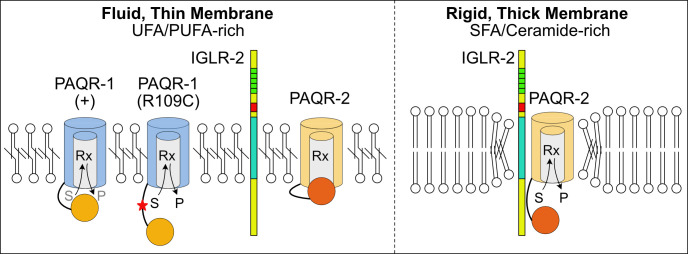
Speculative mechanism of PAQR-1/PAQR-2 regulation.We propose that the cytoplasmic domain (orange/red circles) can regulate access to the catalytic site (Rx) located within the cavity formed by the seven transmembrane domains of PAQR-1/2. In PAQR-1(+), the regulatory domain partially blocks access, resulting in a small rate of conversion of the substrate (S) to signaling product (P). The R109C mutation causes a conformational change in the cytoplasmic regulatory domain, providing greater access to the catalytic site, which results in more substrates being converted to signaling products, which explains the gain-of-function nature of this mutation. The activity of PAQR-1 is not affected by membrane composition, but is rather dose-dependent. In fluid/thin membranes, the PAQR-2 and IGLR-2 proteins readily diffuse within membranes and do not form stable complexes, though they may occasionally interact with each other; the PAQR-2 cytoplasmic inhibitory domain blocks access to the active site under these conditions. In rigid/thick membranes, the PAQR-2 protein causes local deformations of the lipid bilayer that stabilize its interaction with IGLR-2, forming energetically favored signaling nexus; the PAQR-2 cytoplasmic inhibitory domain is displaced through its interaction with IGLR-2, freeing access to the catalytic site. The model attempts to explain the regulation of the hydrolase activity (e.g. ceramidase) that likely provides a ligand for downstream targets; PAQR-1 and PAQR-2 may have additional common interaction partners (not depicted) that explain why PAQR-2 can act as an inhibitor of PAQR-1(R109C) when IGLR-2 is absent.